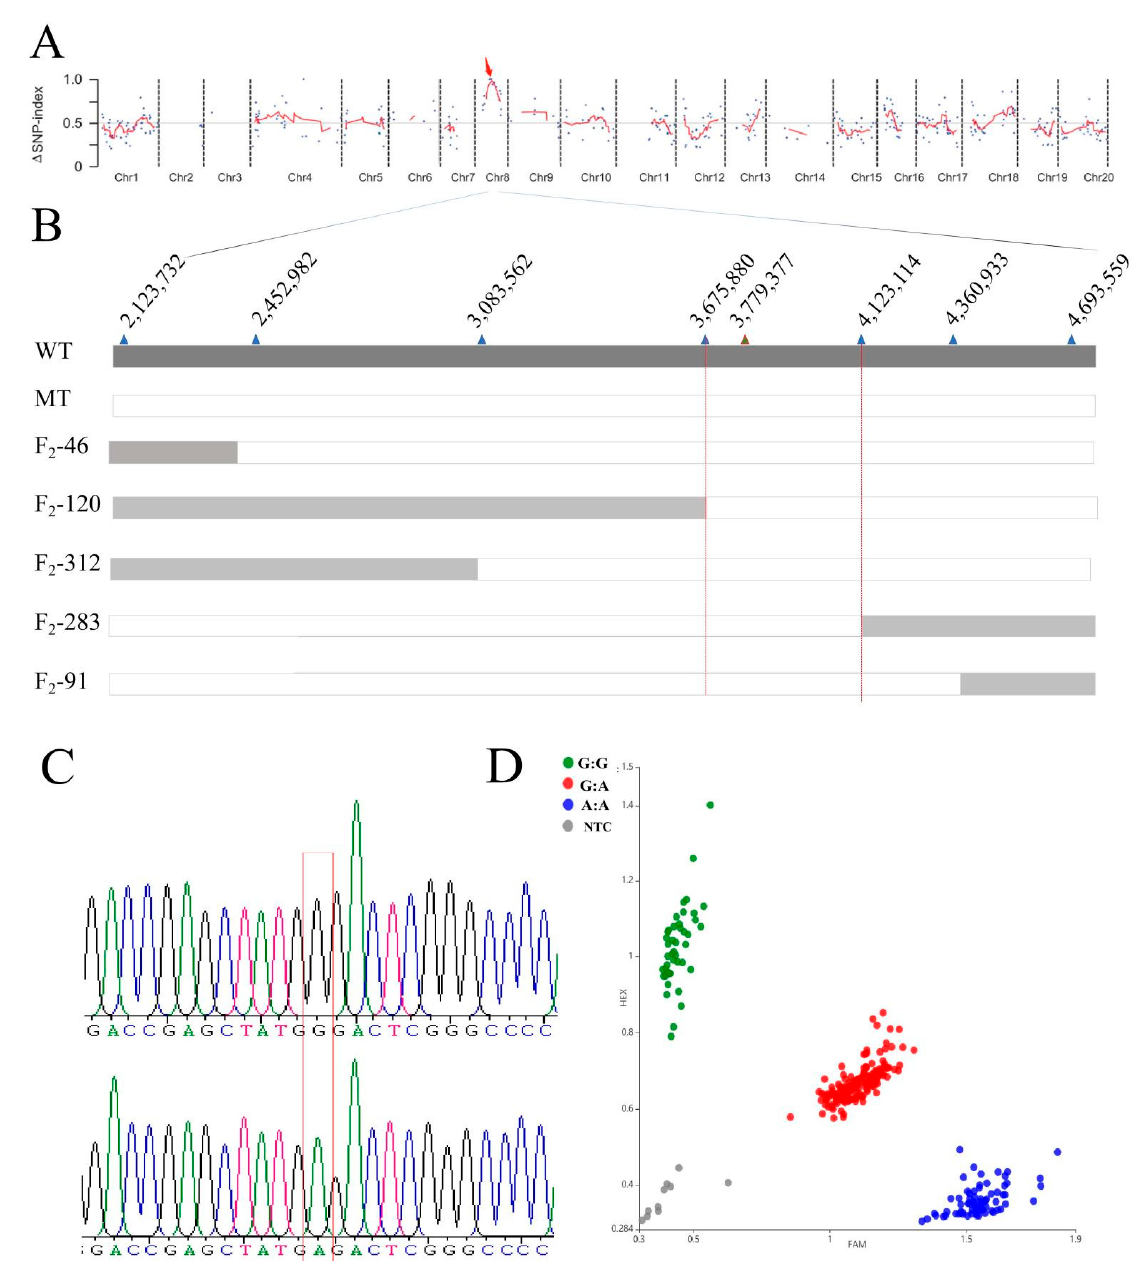
Figure 3. Mapping of the dwarfism gene CmaSI1 . ( A ), Delta SNP-index distribution on chromosome 8. ( B ), Fine mapping of CmaSI1 . The numbers within brackets indicate the number of recombinants. ( C ), The SNP found between the two parents on Chr08:3,779,377 was confirmed by sanger sequencing. ( D ), The corresponding KASP marker showed cosegregation in the F 2 population.